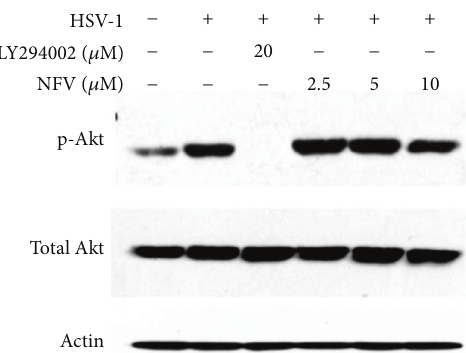
Figure 3: Decreased Akt activation does not account for the ability of NFV to inhibit HSV-1 viral replication. HSV-1 infection of Vero cells resulted in an increase in levels of phosphorylated (p)-Akt at 2 hours compared to uninfected cells. Although the Akt inhibitor LY294002 could completely suppress Akt phosphorylation in HSV- 1 infected cells, NFV did not substantially reduce the levels of p-Akt even at drugs concentrations that potently block virus